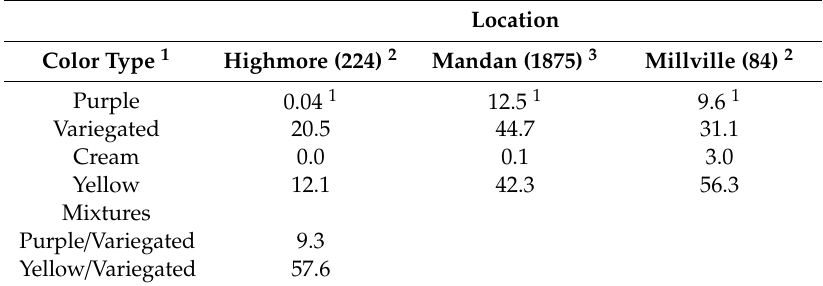
Table 2. Occurrence (%) of flower color types in the Grand River National Grassland population, based on individual plant (Mandan) or family row (Highmore and Millville)